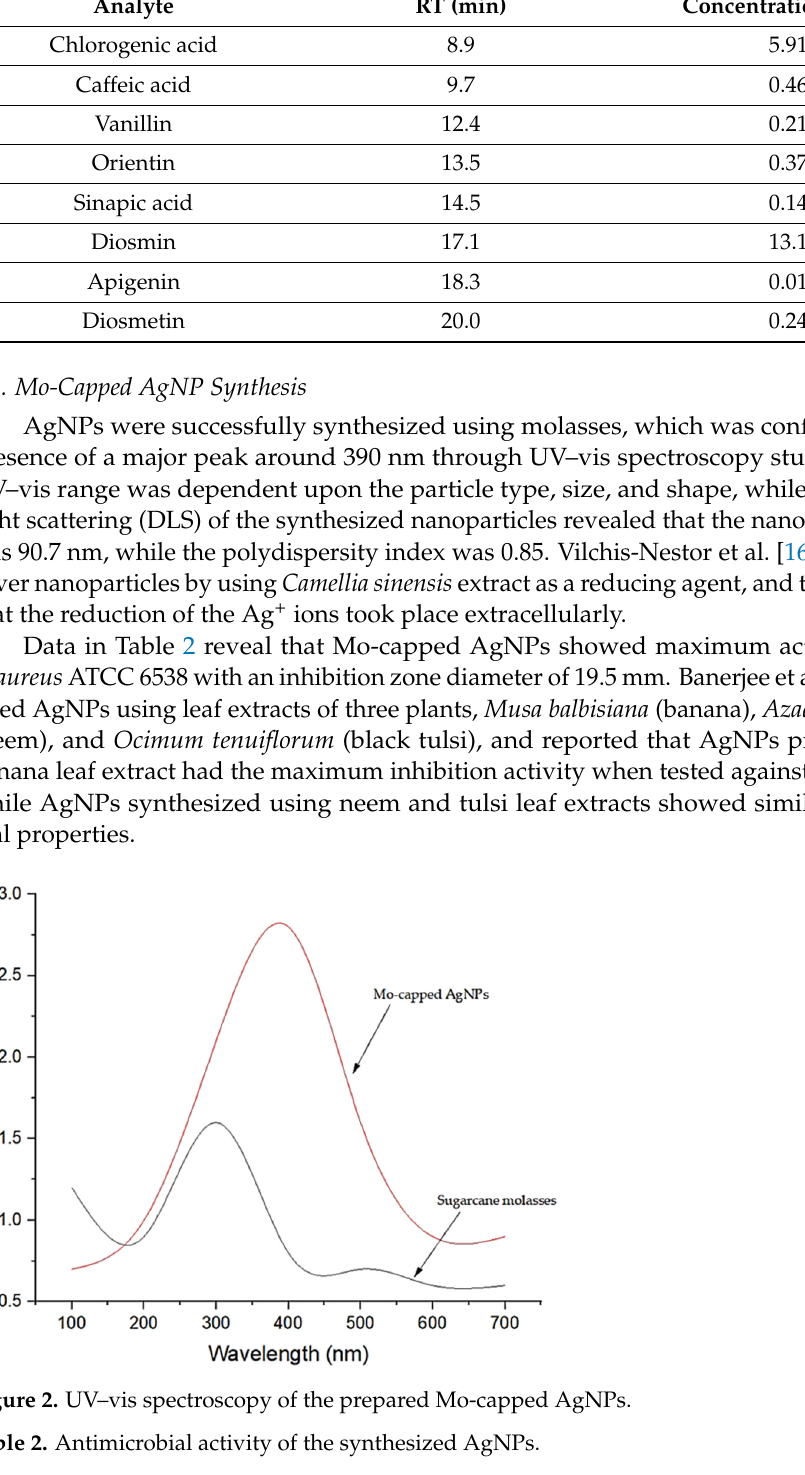
Table 1. LCMS analysis of the polyphenolic compounds in the obtained sugarcane molasses.